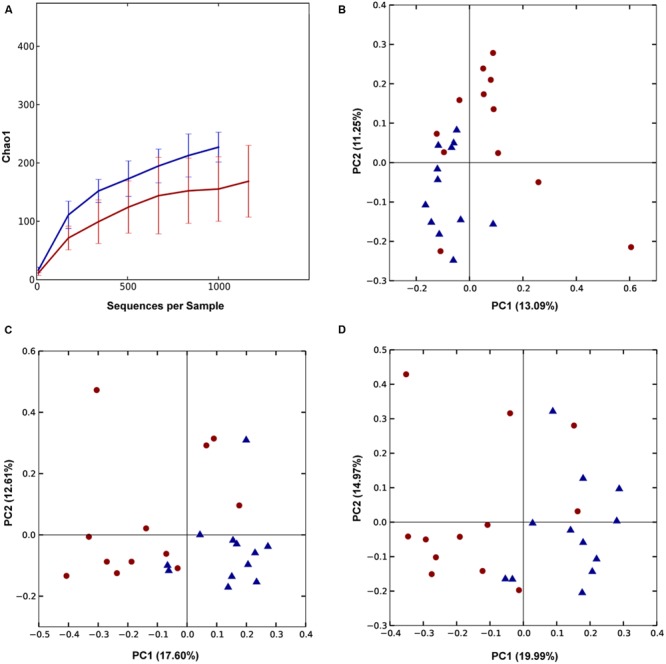
Trial 1: Differences between high (red) and low (blue) FCR microbial communities. (A) Alpha diversity metric Chao1 was significantly (p = 0.0021) higher in low FCR birds. (B) Unweighted UniFrac (p = 3E-4) PCoA plot; (C,D) PCoA plot of beta diversity using Canberra distance at a genus (C) and family level (D). Communities of high and low FCR birds were significantly different based on Canberra distance at a genus (p = 7E-5) or family level (p = 3.9E-4).